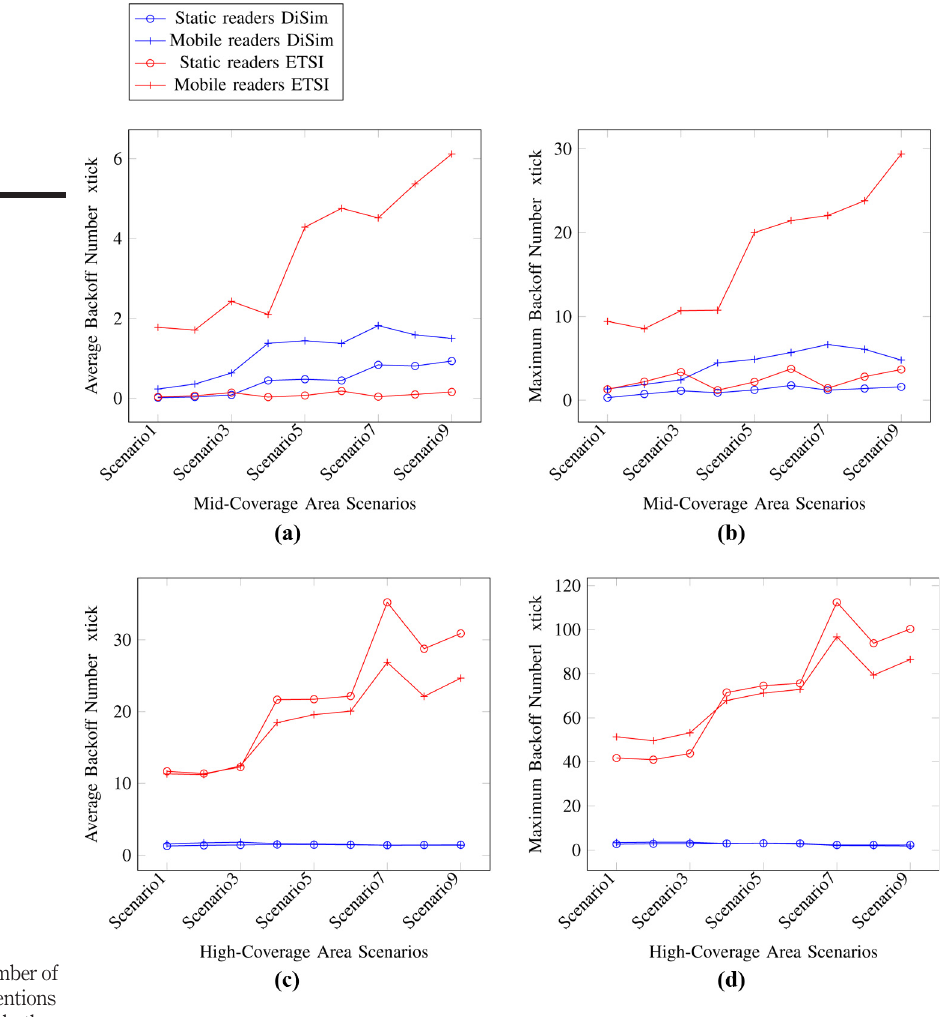
Figure A4. Average and maximum number of backoffs/contentions per reader, for both mid- and high- coverage